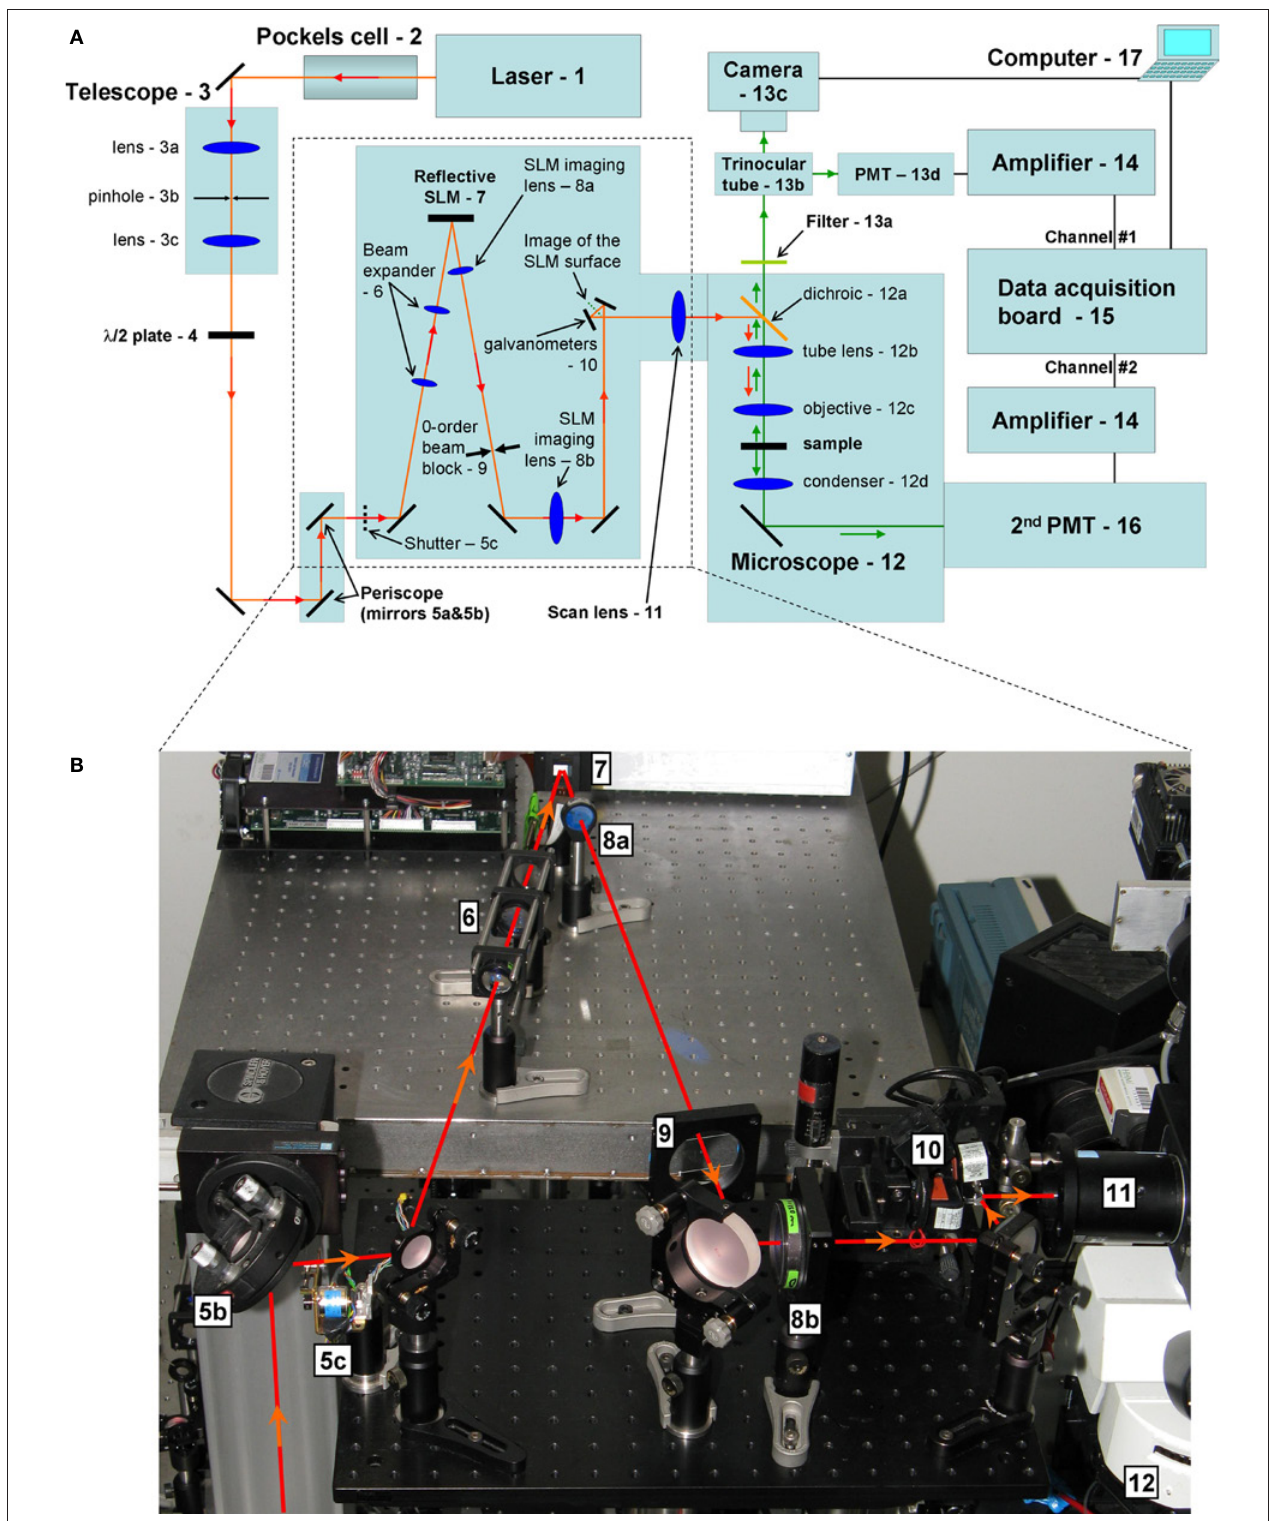
FIGURE 1 | Optical design of SLM microscope. (A) Optical diagram of our system. (B) Photograph of the SLM bix highlighted on panel (A) . Red lines illustrates laser excitation pathway. We describe below with some detail